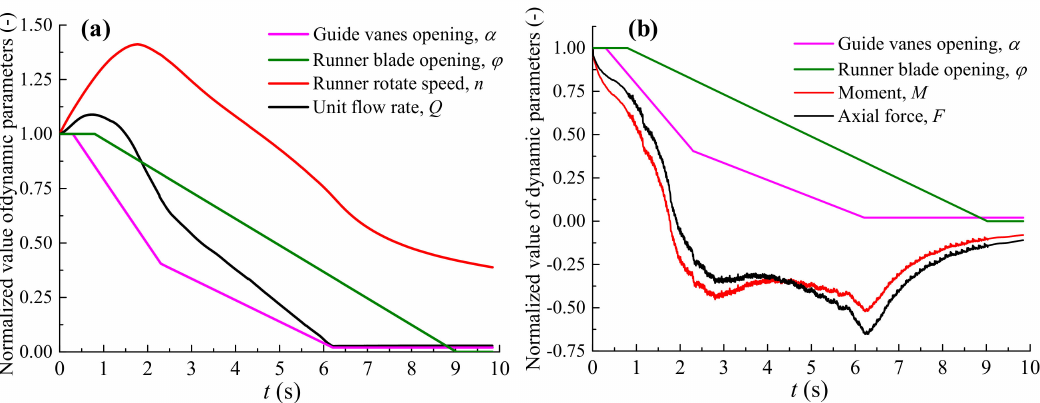
Figure 10. Variation of normalized dynamic parameters in the load rejection process, ( a ) the variations of runner rotate speed and unit flow rate, ( b ) the variations of moment and axial